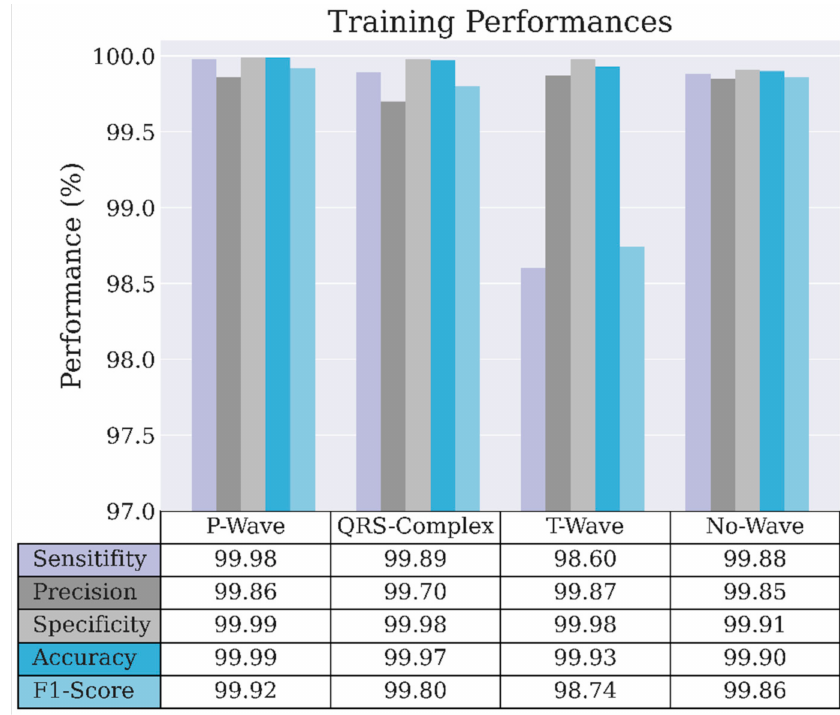
Figure 4. Model evaluation for the training process in normal ECG waveform.